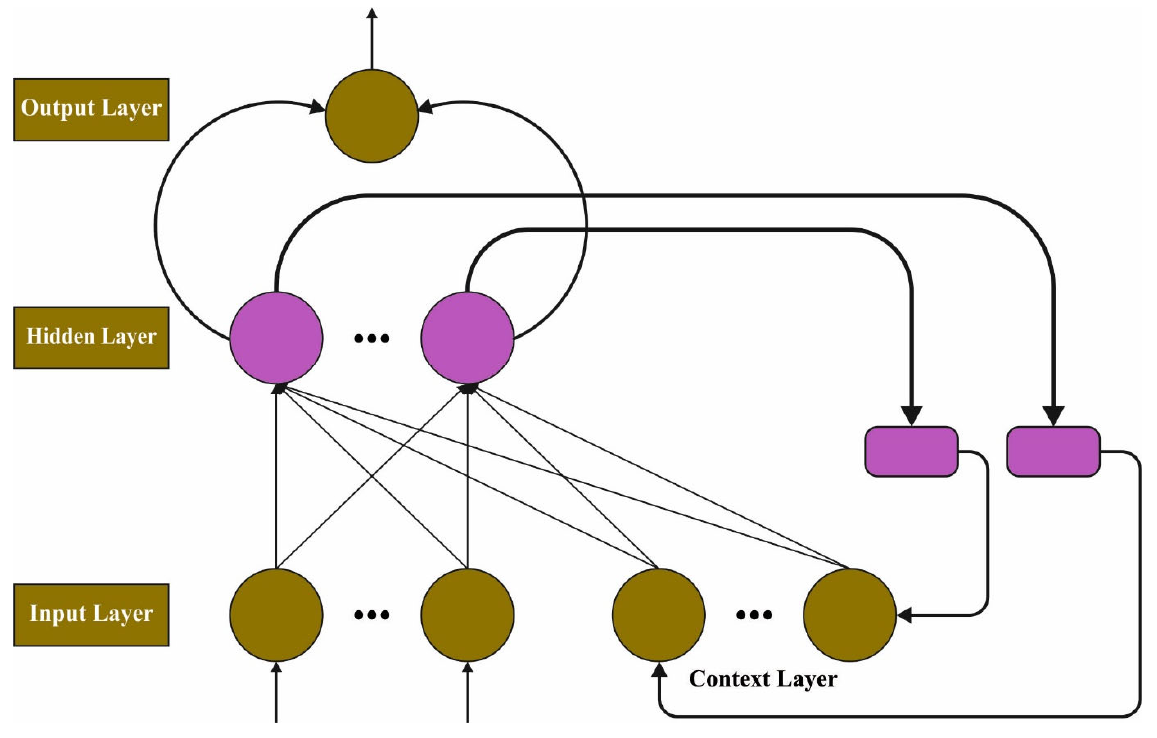
Figure 2. Structure of the ENN.